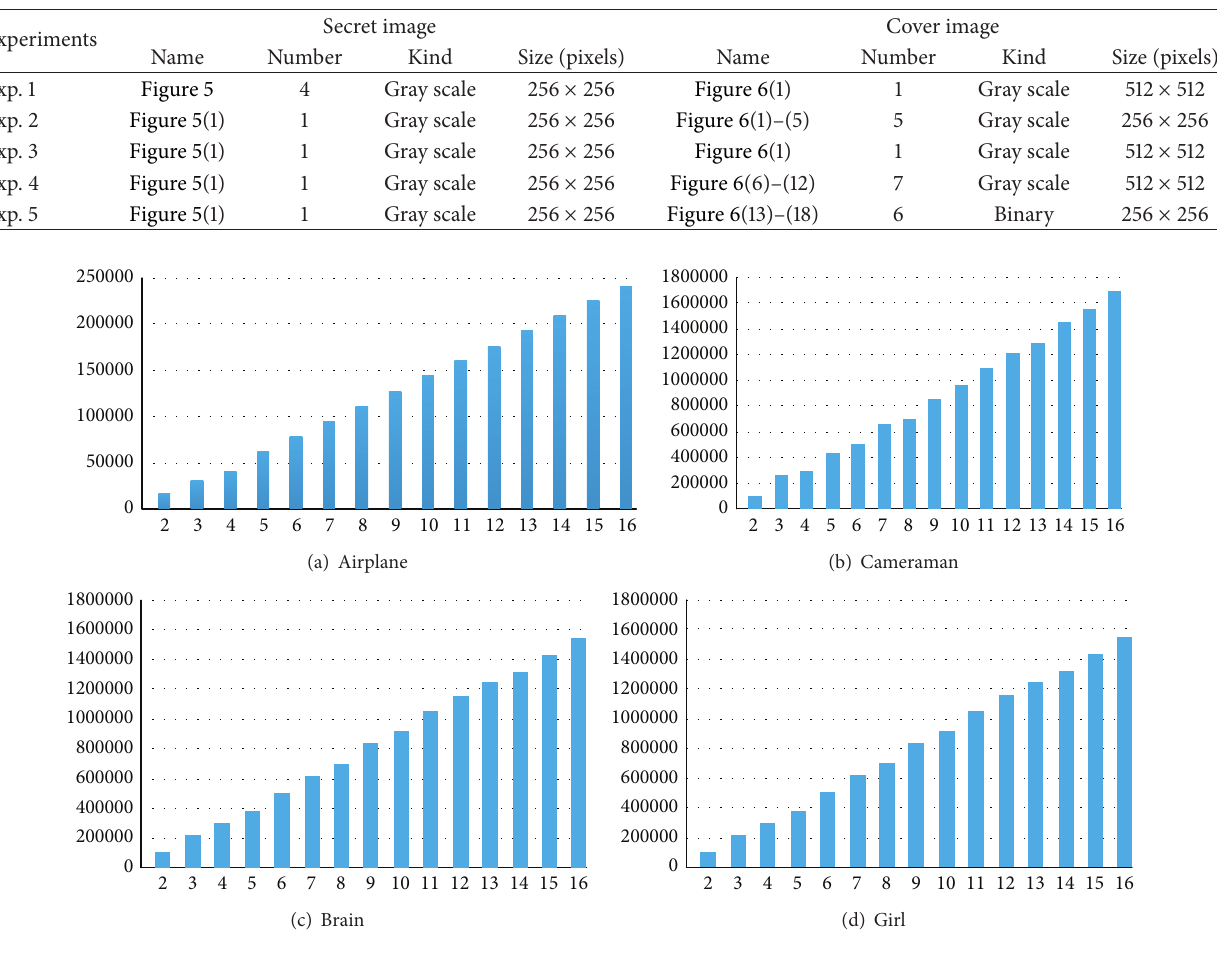
Table 5: Used images.